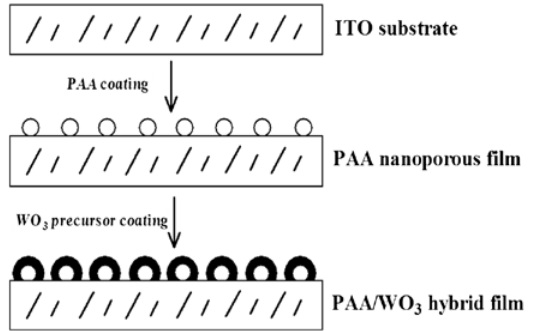
films in a PC solution containing 3